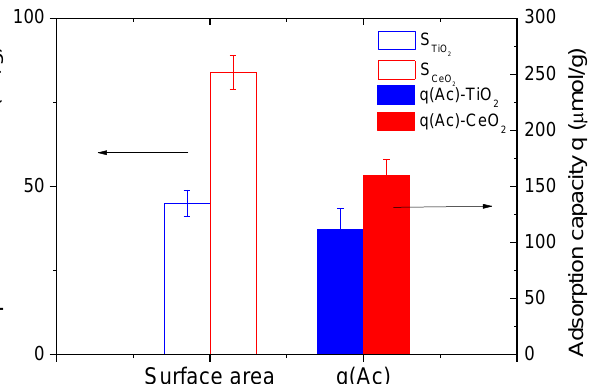
Figure 3. Features of TiO 2 and CeO 2 surfaces. On the left, specific surface areas of TiO 2 (S TiO2 ) and CeO 2 (S CeO2 ) expressed in m 2 /g. On the right, quantity of irreversibly adsorbed acetone (q) expressed in µ mol/g on TiO 2 (q(Ac)-TiO 2 ) and CeO 2 (q(Ac)-CeO 2 ).